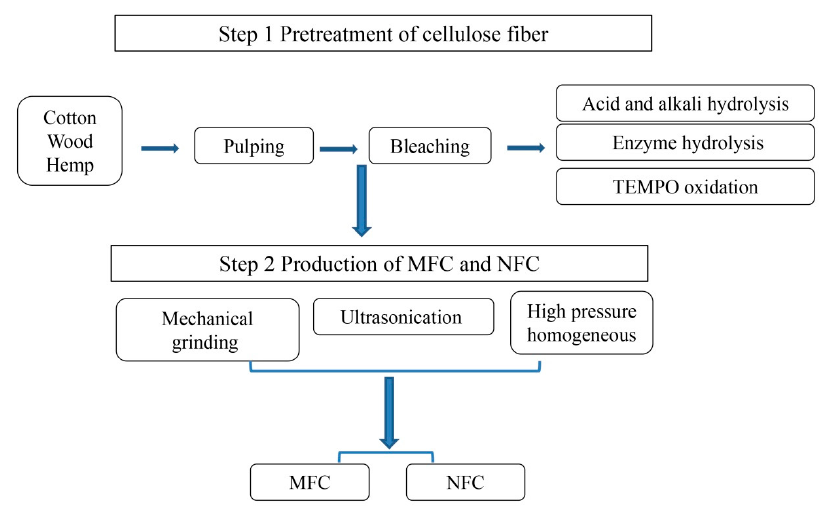
Figure 4. The steps of extracting microfibrillated cellulose (MFC) and NFC from natural plants. Table 1. Comparison of different preparation methods with different raw materials.